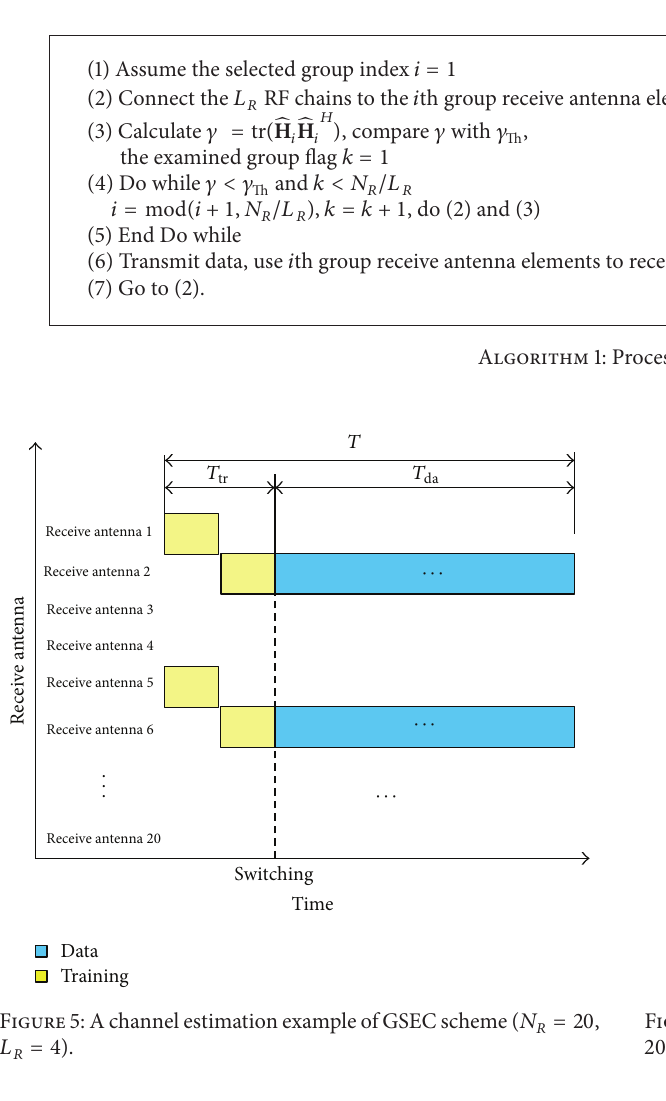
( 𝜌 = 20 dB) ( 𝑁 𝑇 = 4 , Th